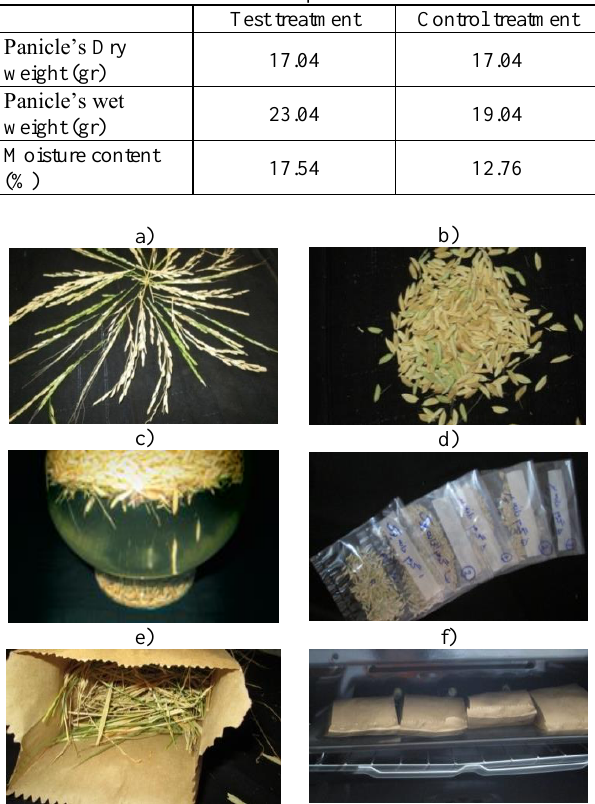
Figure 9: Performance analysis of harvested samples; a) No. of panicles in canopy, b) No. of grains in panicles, c) Discrimination of solid and hollow grains in a bottle of water, d,e) Drying paddies in oven.